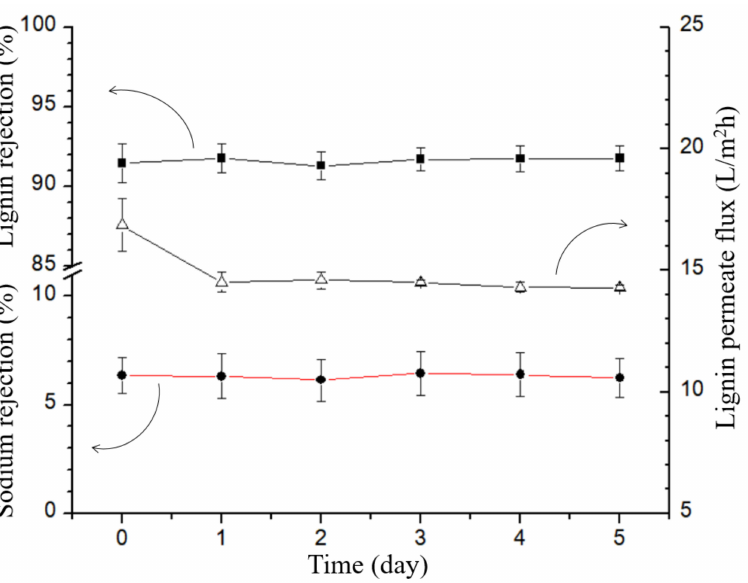
Figure 12. Retention of sodium ions, retention of lignin and lignin permeate flux in lignin wastewater. For the average statistics, each experiment was run three times in the same